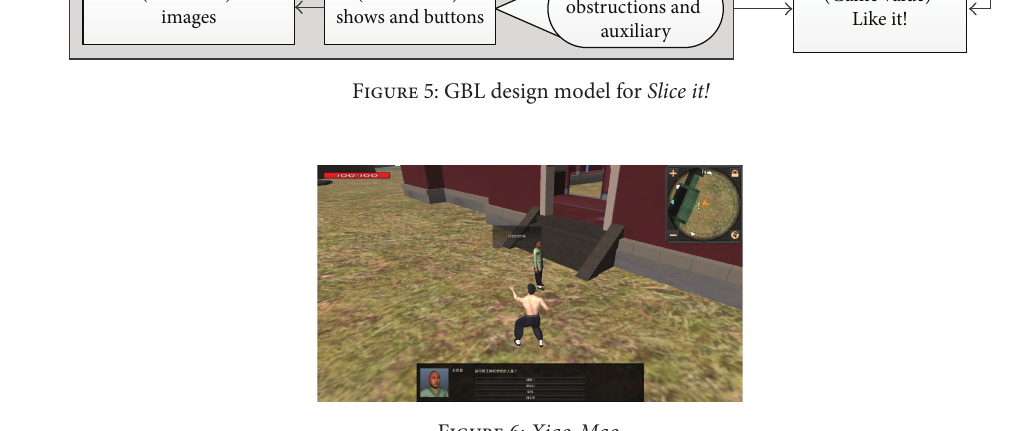
Figure 6: Xiao-Mao .